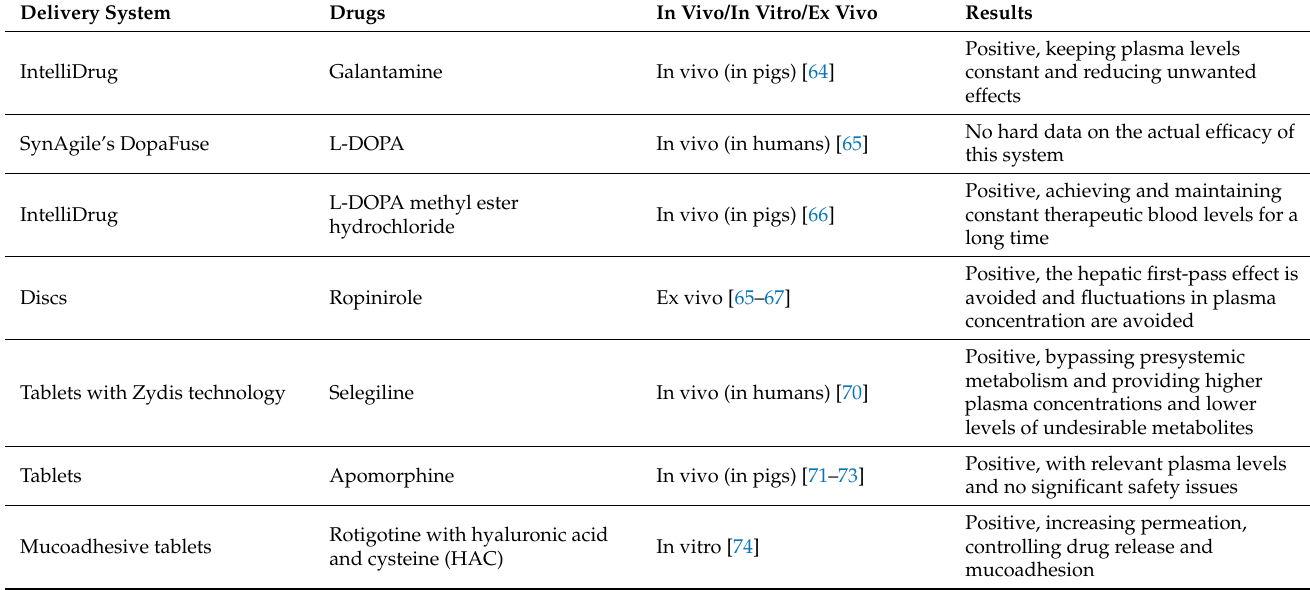
Table 2. Trials investigating Transbuccal Drug Delivery Systems in Parkinson’s Disease and Alzheimer’s